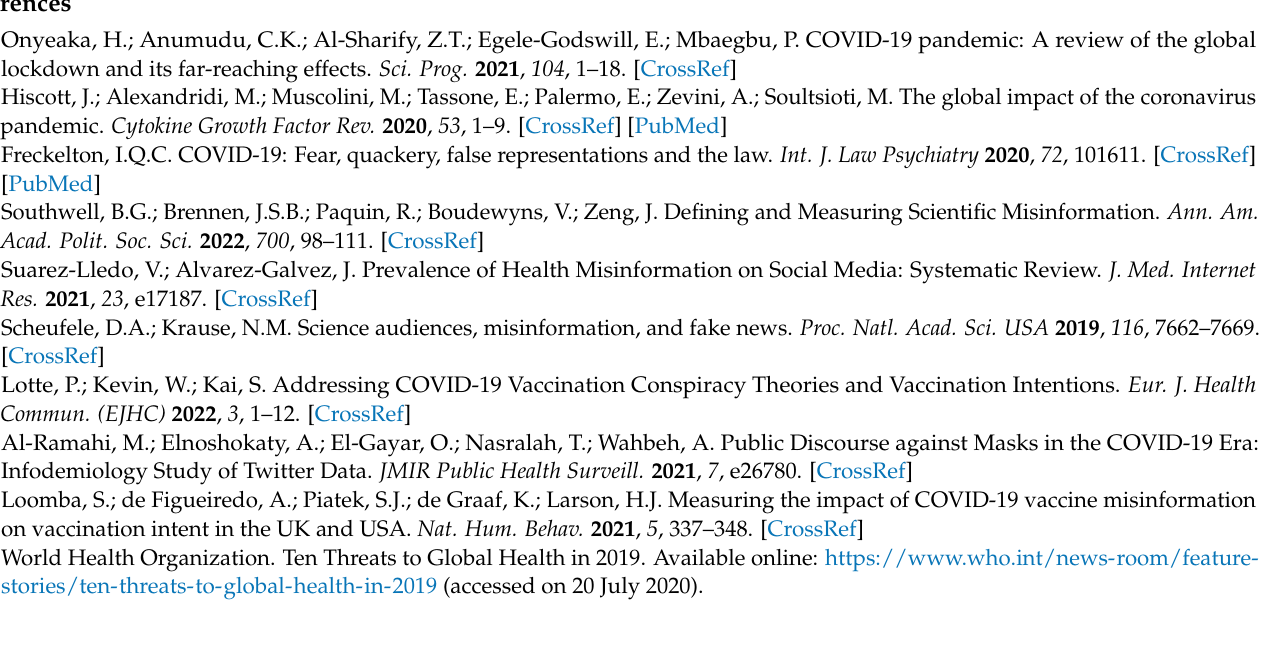
Table S1: questions used in the survey. Questions highlighted with an asterisk (*) were used for the calculation of the preventive behaviour score. Questions highlighted with two asterisks (**) were used for the calculation of the scientific misinformation score; Table S2: demographic characteristics of the study